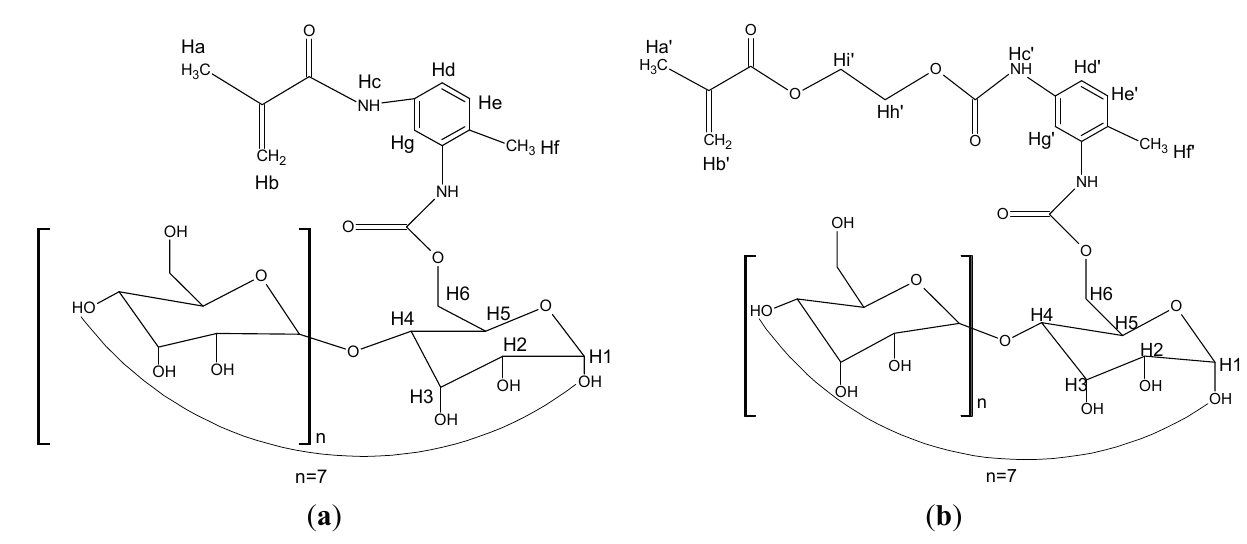
Figure 1. 1 H NMR spectra of ( a ) MAA- β -CD; and ( b ) HEMA- β -CD.